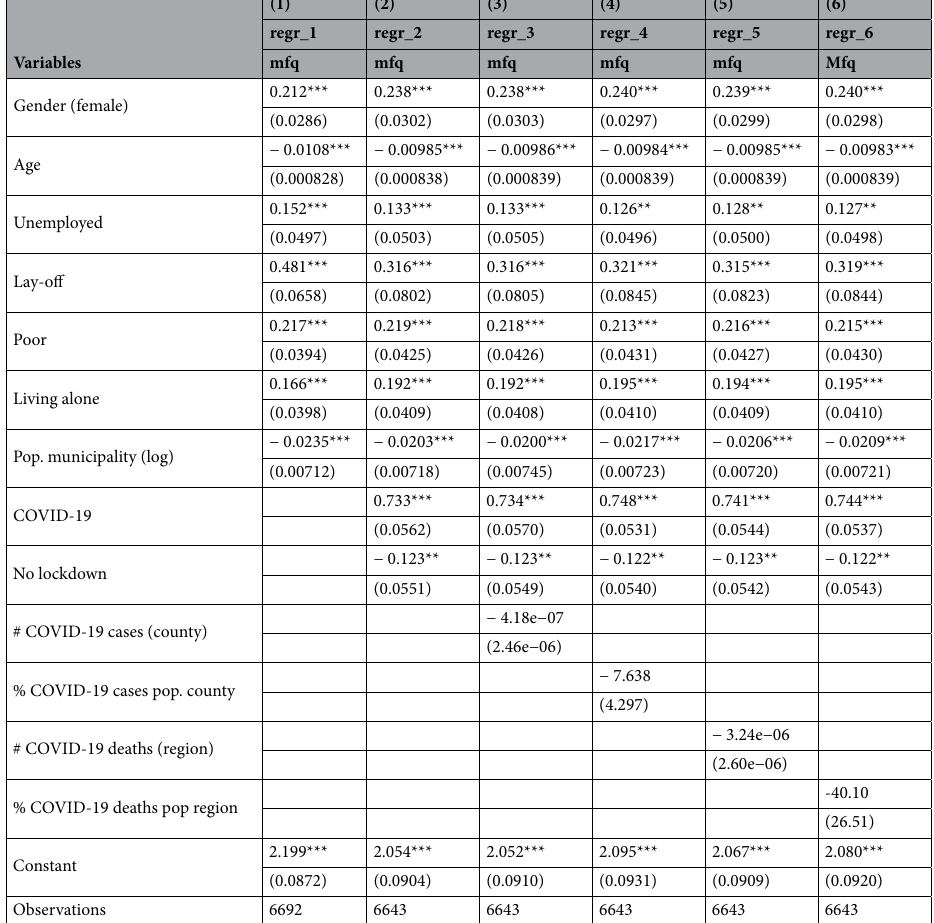
Table 5. Result of econometric models on the SMFQ score. ( * ) Note: The estimates in the table refer to Poisson count models with double censoring (left at 0, right at 26), sample weights and robust standard errors. The dependent variable is the SMFQ score. For each variable, the coefficient, the standard error (in parentheses), and the level of significance are reported as follows: *** significant at 99%; ** significant at